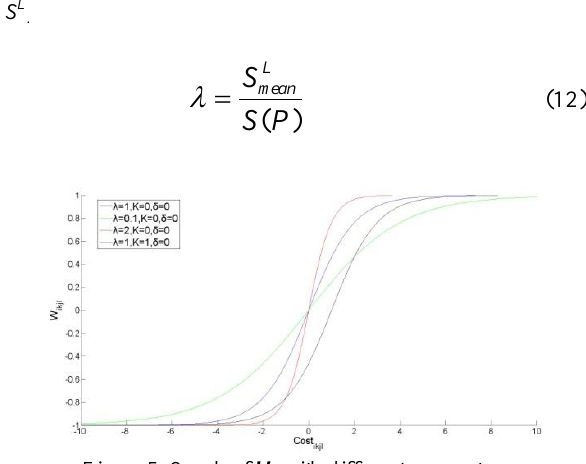
Figure 5. Graph of W with different parameters.